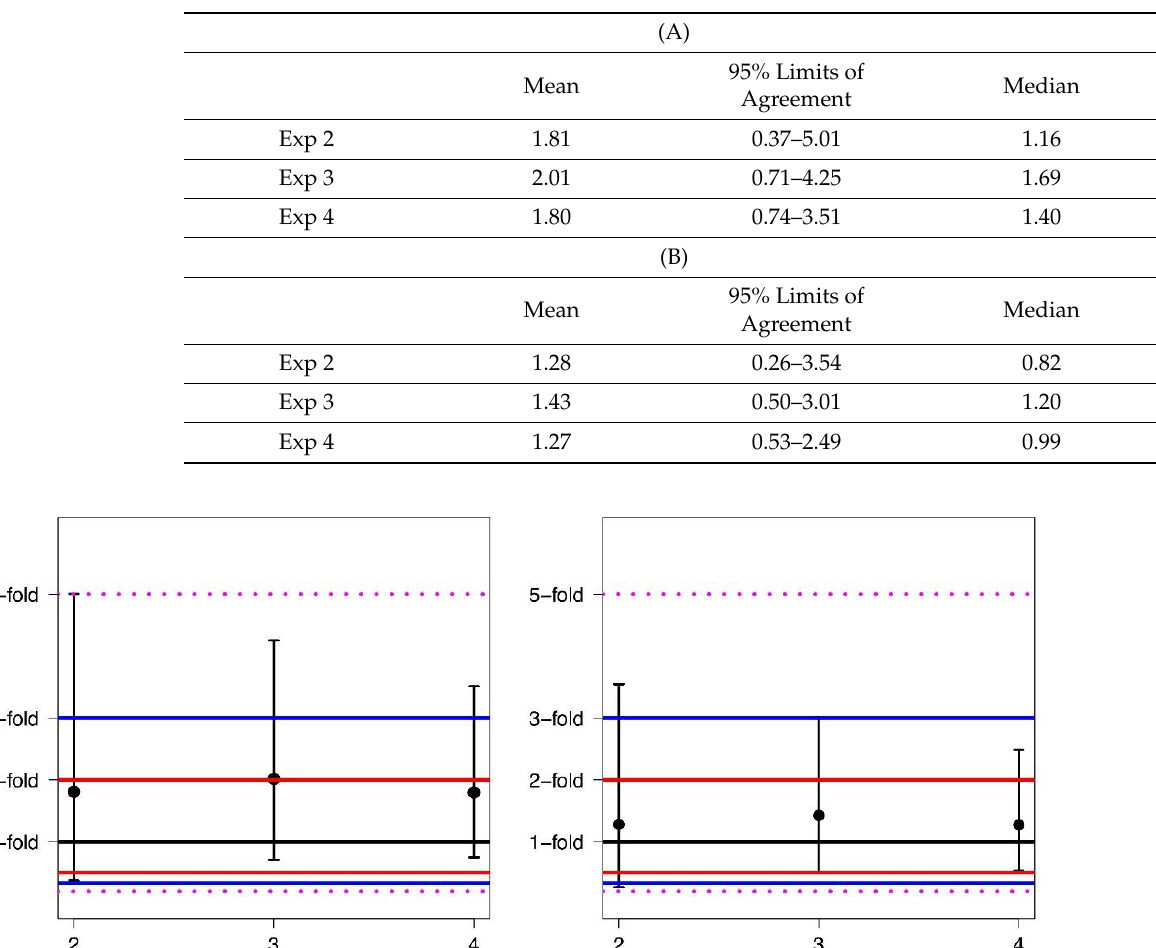
Table 3. Fold difference (FD) before (A) and after conversion (B). We report the 95% limits ofagree- ment, the mean of the ‘fold differences’ (FD = B/A), and the median value for each experiment.